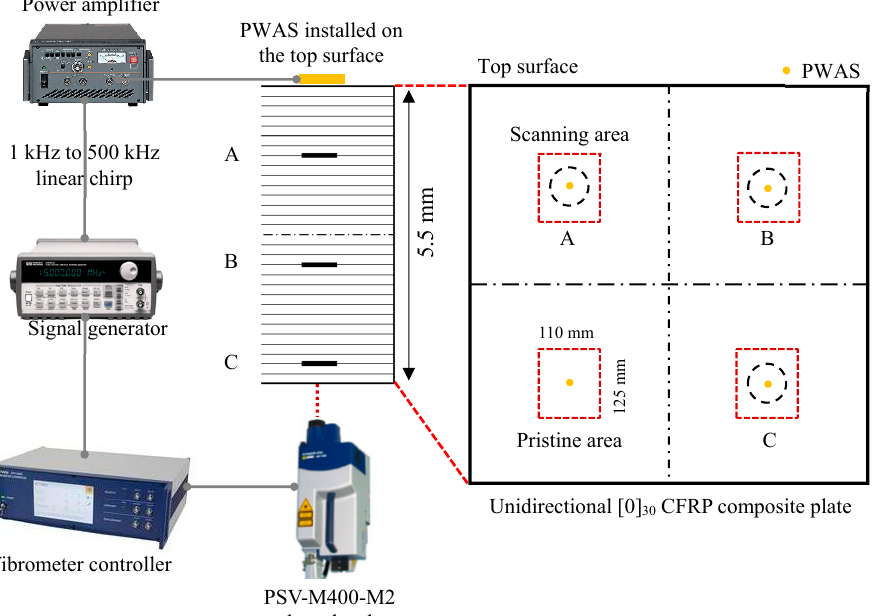
Figure 12. Experimental setup on the unidirectional [0] 30 CFRP composite plate using the scanning laser Doppler vibrometer (SLDV) measurement.